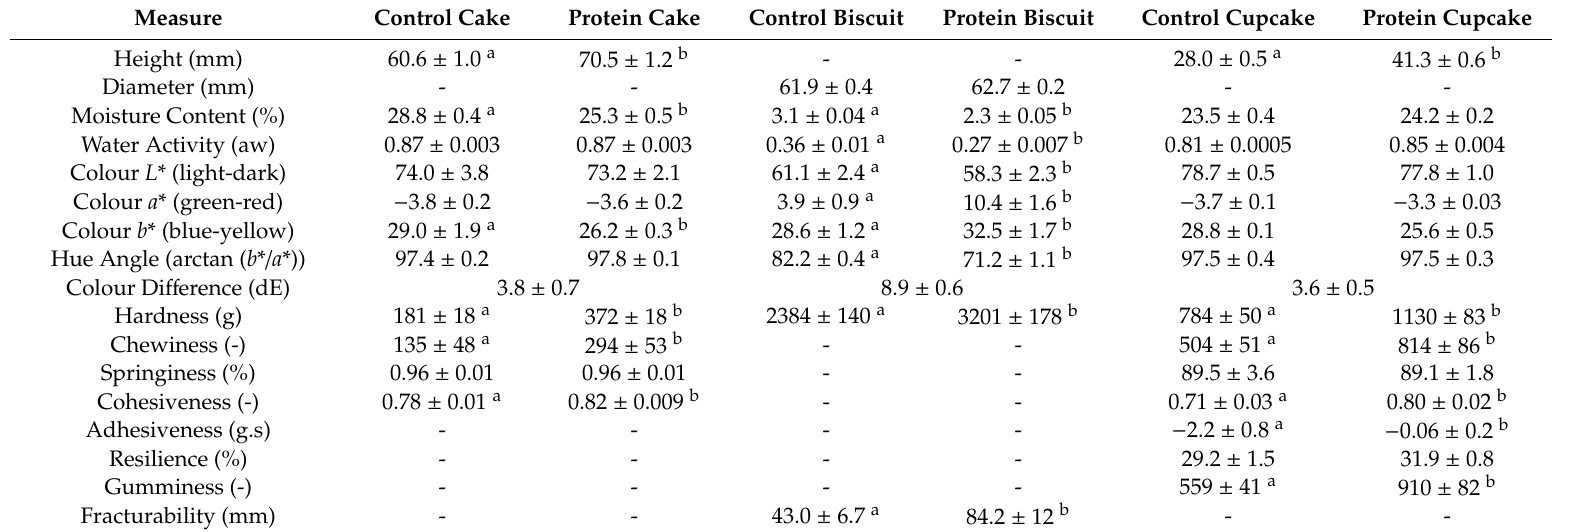
Table 4. Physical properties of cakes, biscuits and